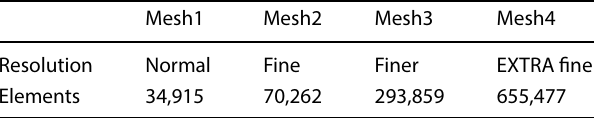
Table 2 The number of elements for the four different meshes used to study mesh convergence Mesh1